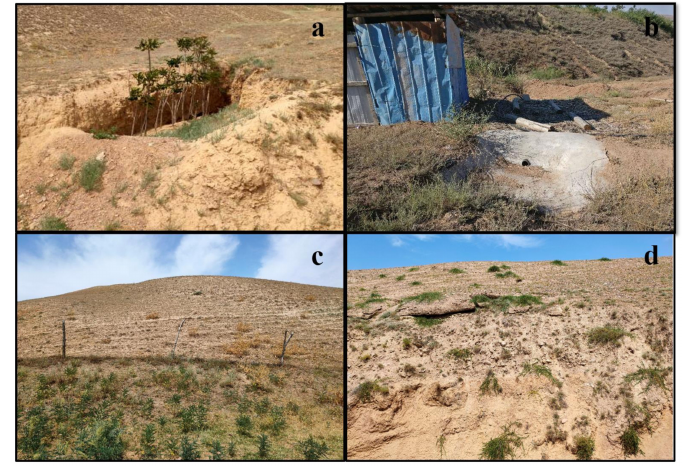
Figure 6. Suitable rainwater harvesting (RWH) techniques in arid rangeland. ( a ) earth check dam; ( b ) water cellar; ( c ) fence; ( d ) vines on the gully